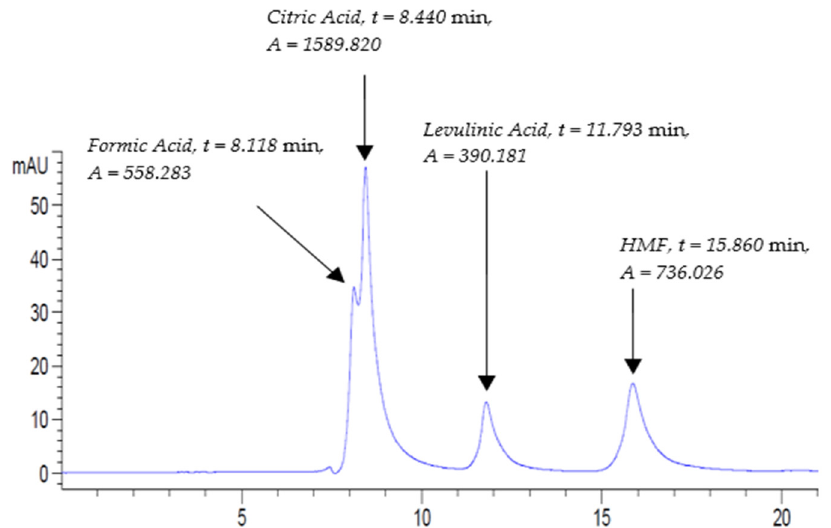
8.118 min, 8.440 min, 11.793 min, and 15.860 min, respectively. Clearly, all analytes eluted